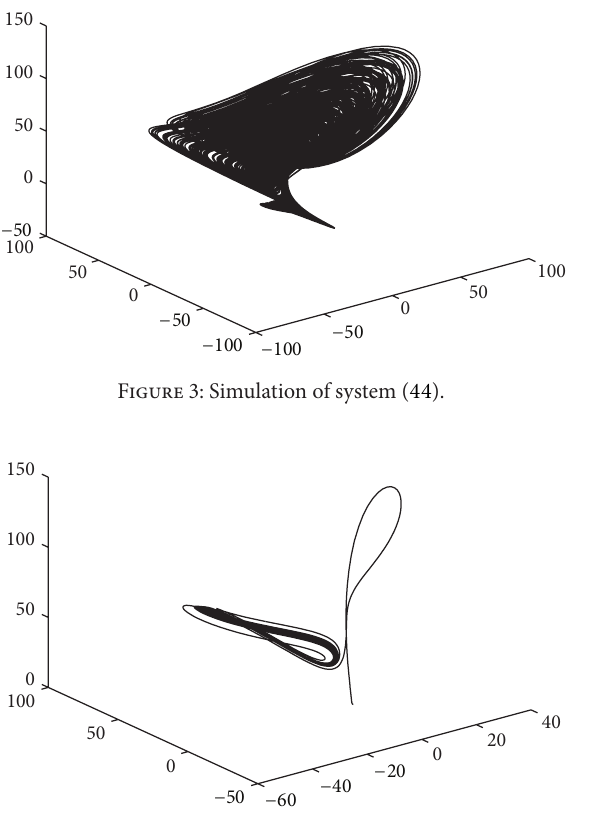
Figure 6: Simulation of system